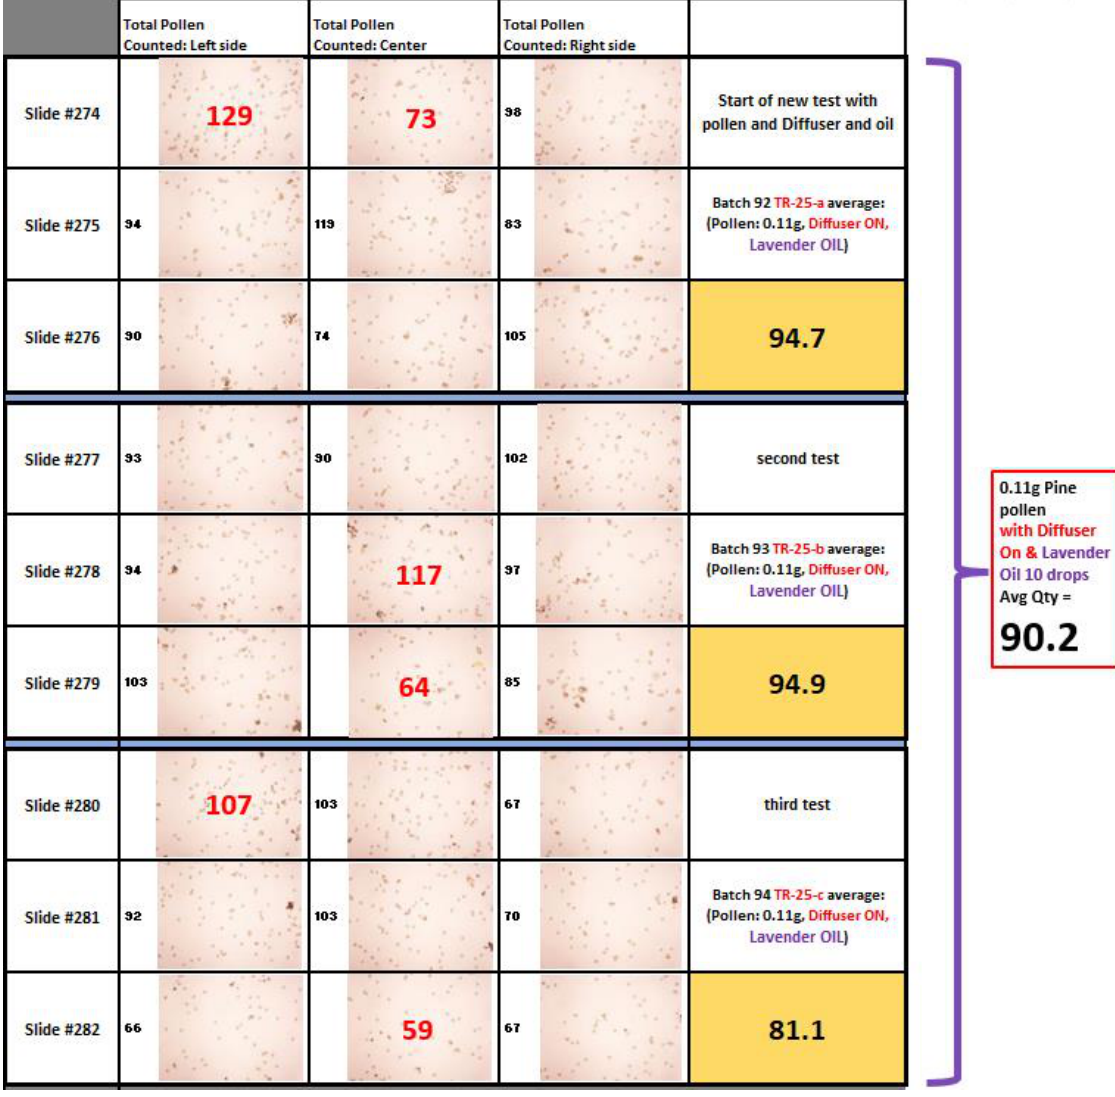
Figure 5. Representation of pollen counts recorded to create one data point.